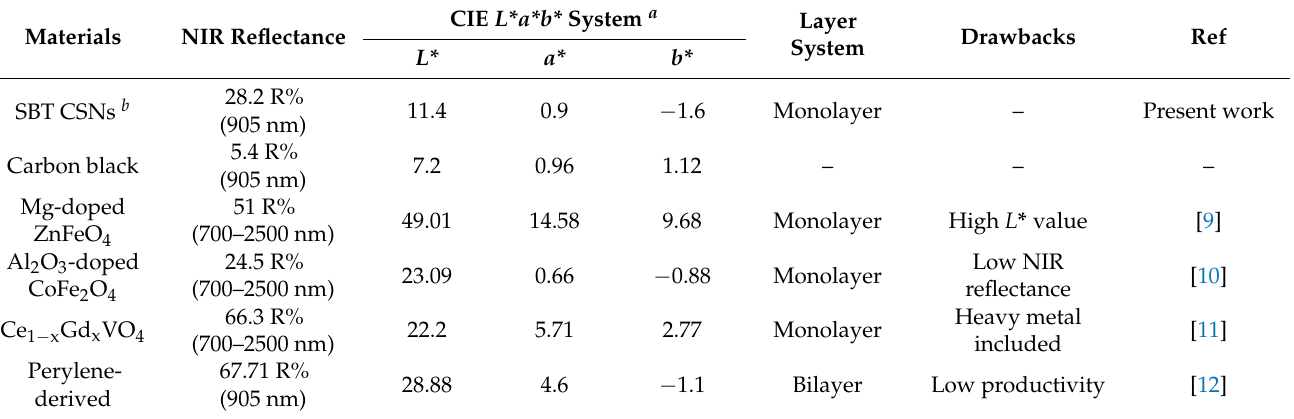
Table 4. Comparison of NIR properties of SBT CSNs with other dark-tone LiDAR-detectable mate- rials.